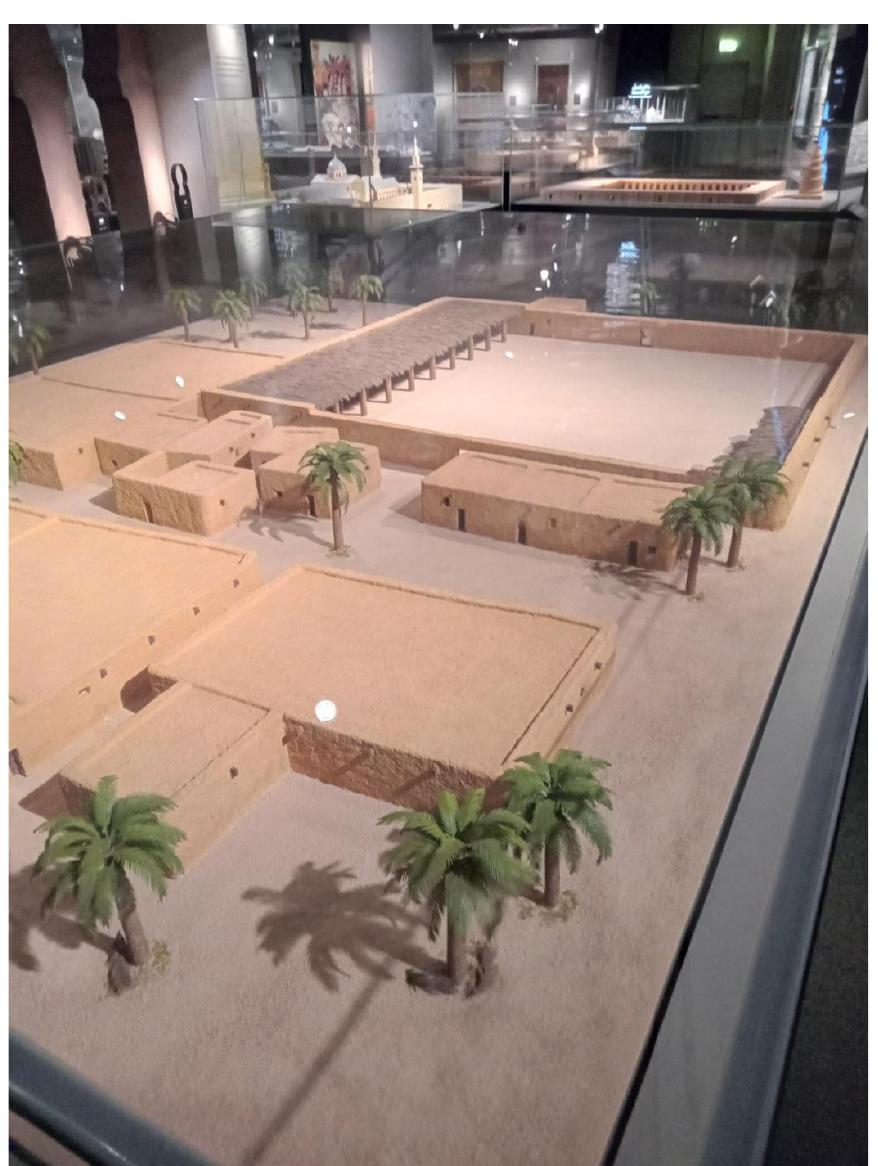
Figure 23. The collection of Islamic art in the King Abdulaziz Center for World Culture (Ithra), Dhahran, Saudi Arabia. Model reconstituting the original mosque and house of the Prophet, Medina, Arabia. Photo of the author.